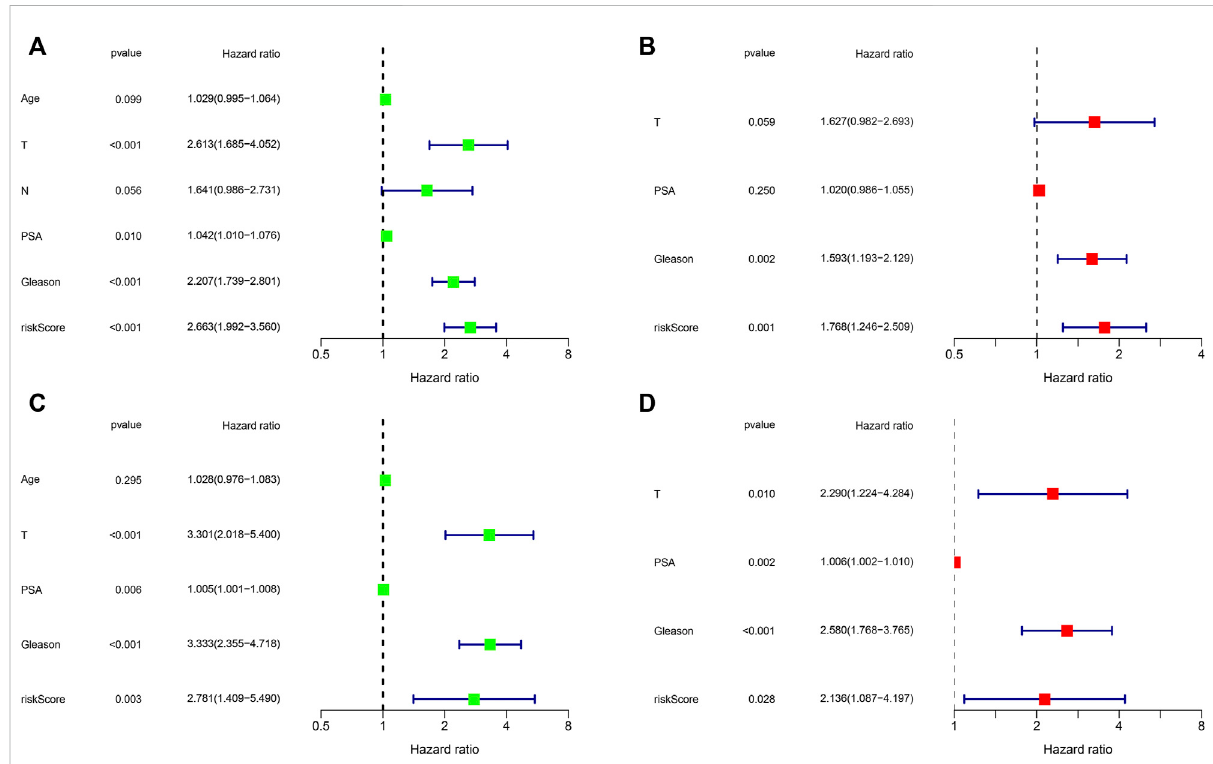
FIGURE 7 Independent prognostic value of risk score and clinical features. (A,B) Exploring independent prognostic factors using univariate (A) and multivariate (B) Cox regression analysis in TCGA cohort. (C,D) Validation of independent prognostic factors using univariate (C) and multivariate (D) COX regression analysis in MSKCC